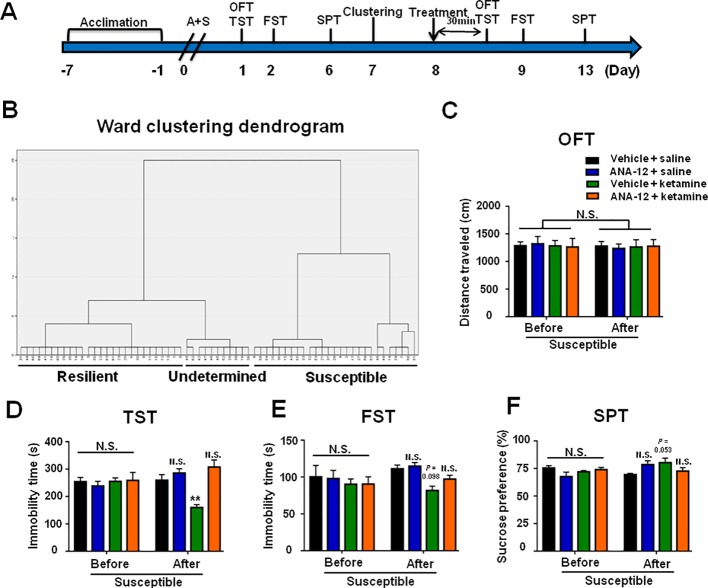
ANA-12 attenuated ketamine-induced beneficial effects on POD-like symptoms in depression susceptible mice. (A) The schedule of treatment and behavioral tests. OFT and TST were performed on day 1 and 8 after A+S, respectively; FST was performed on day 2 and 9 after A+S, respectively; SPT was performed on days 6 and 13 after A+S, respectively. Vehicle or saline (10 ml/kg), Ketamine (10 mg/kg), or ANA-12 (0.5 mg/kg) was intraperitoneally injected at a single dose on day 8. (B) Dendrogram of hierarchical clustering analysis. A total of 44 mice after A+S were divided into depression susceptible, resilient, and undetermined groups by TST, FST, and SPT results of hierarchical clustering analysis. (C) OFT [time: F
(1,
20) = 0.1232, P = 0.7293; group: F
(3,
20) = 0.0042, P = 0.9996; interaction: F
(3,
20) = 0.09238, P = 0.9634]. (D) TST [time: F
(1,
20) = 0.0211, P = 0.8859; group: F
(3,
20) = 3.35, P = 0.0396; interaction: F
(3,
20) = 17.93, P < 0.0001]. (E) FST [time: F
(1,
20) = 1.67, P = 0.211; group: F
(3,
20) = 1.878, P = 0.1659; interaction: F
(3,
20) = 1.16, P = 0.3497]. (F) SPT [time: F
(1,
20) = 1.856, P = 0.1882; group: F
(3,
20) = 0.7368, P = 0.5424; interaction: F
(3,
20) = 3.35, P = 0.0396]. Data are shown as mean ± S.E.M. (n = 6 per group). **P < 0.01 A+S: anesthesia and surgery; ANA-12: N-[2-[[(Hexahydro-2-oxo-1H-azepin-3-yl)amino]carbonyl] phenyl]-benzo[b] thiophene-2-carboxamide; FST, forced swimming test; N.S., not significant; OFT, open field test; POD, postoperative depression; SPT, sucrose preference test; TST, tail suspension test.